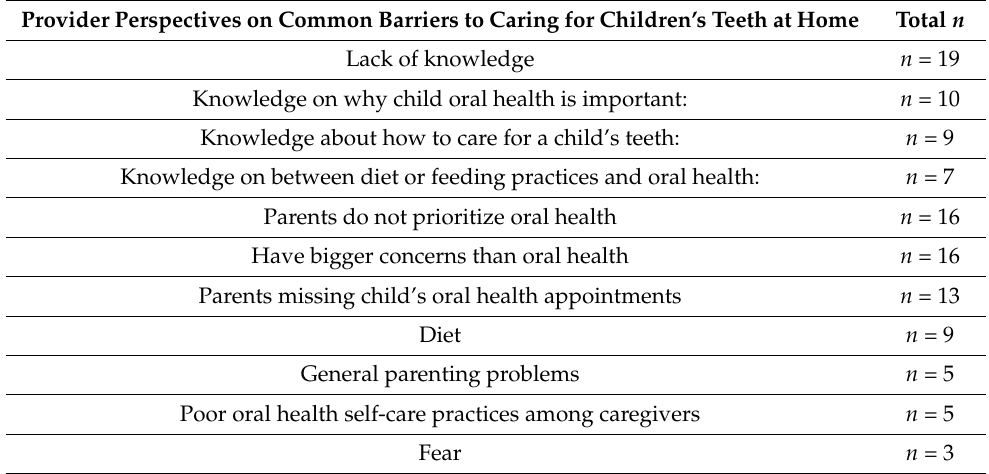
Table 3. Provider perspectives on common barriers to caring for children’s teeth at home. Provider Perspectives on Common Barriers to Caring for Children’s Teeth at